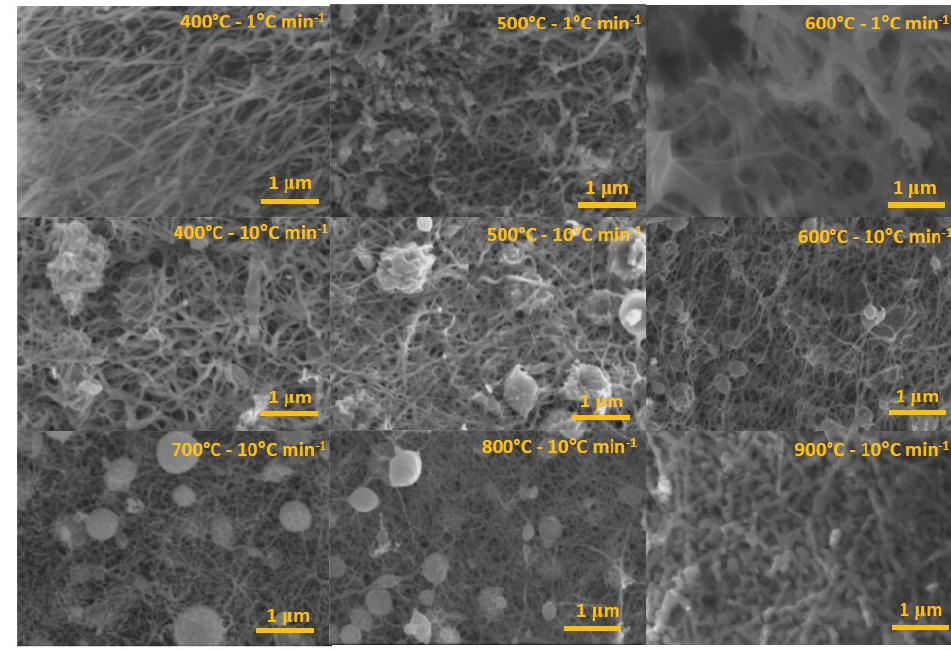
Figure 2. SEM images of the Nb 2 O 5 fibers after the thermal treatments at different temperatures (400–900 ◦ C), using a heating rate of 1 ◦ C min − 1 and 10 ◦ C min − 1